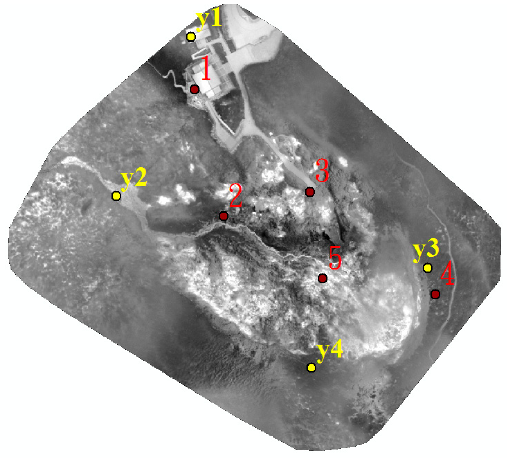
Figure 16. The location of 5 check points for the verification of geometric planimetric accuracy. Table 6. The checked data for the geometric accuracy of thermal orthoimages. Check